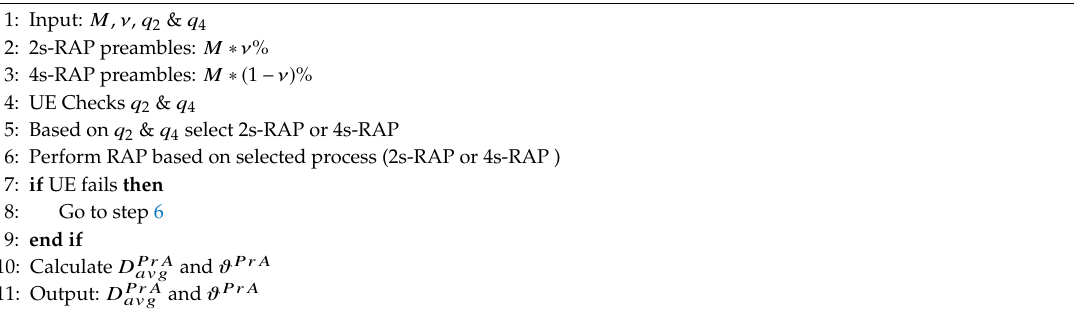
Algorithm 3 2s-RAP and 4s-RAP using preceding algorithm